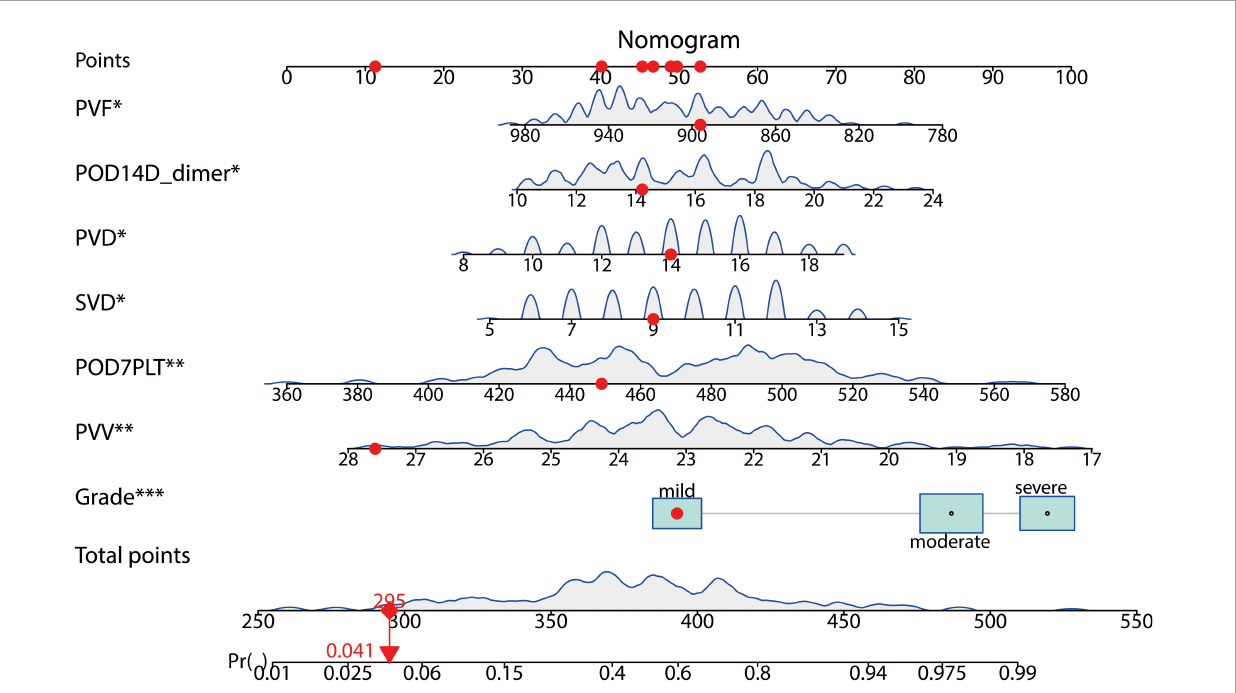
FIGURE4 A predictive model for the risk of PVST in HLD patients. The nomogram gives every predictive variable a score on the point scale. A total score was calculated by summing the points from each variable, marking the estimated probability of PVST occurrence in HLD patients after surgery. For example, the red dots display a 4% risk of thrombosis in the first patient. POD, postoperative day; PVD, portal vein diameter; SVD, splenic vein diameter; PVV, portal vein velocity; PVF, portal vein flow. The “*”, “**”, and “***” symbols mean P < 0.05, P < 0.01, and P < 0.001, respectively.